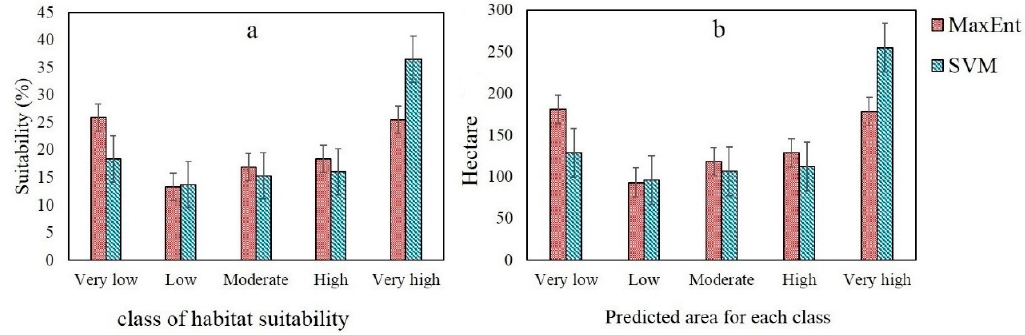
Figure 4. Percentages of different habitat suitability classes ( a ), and ( b ) predicated area for each class of habitat suitability.